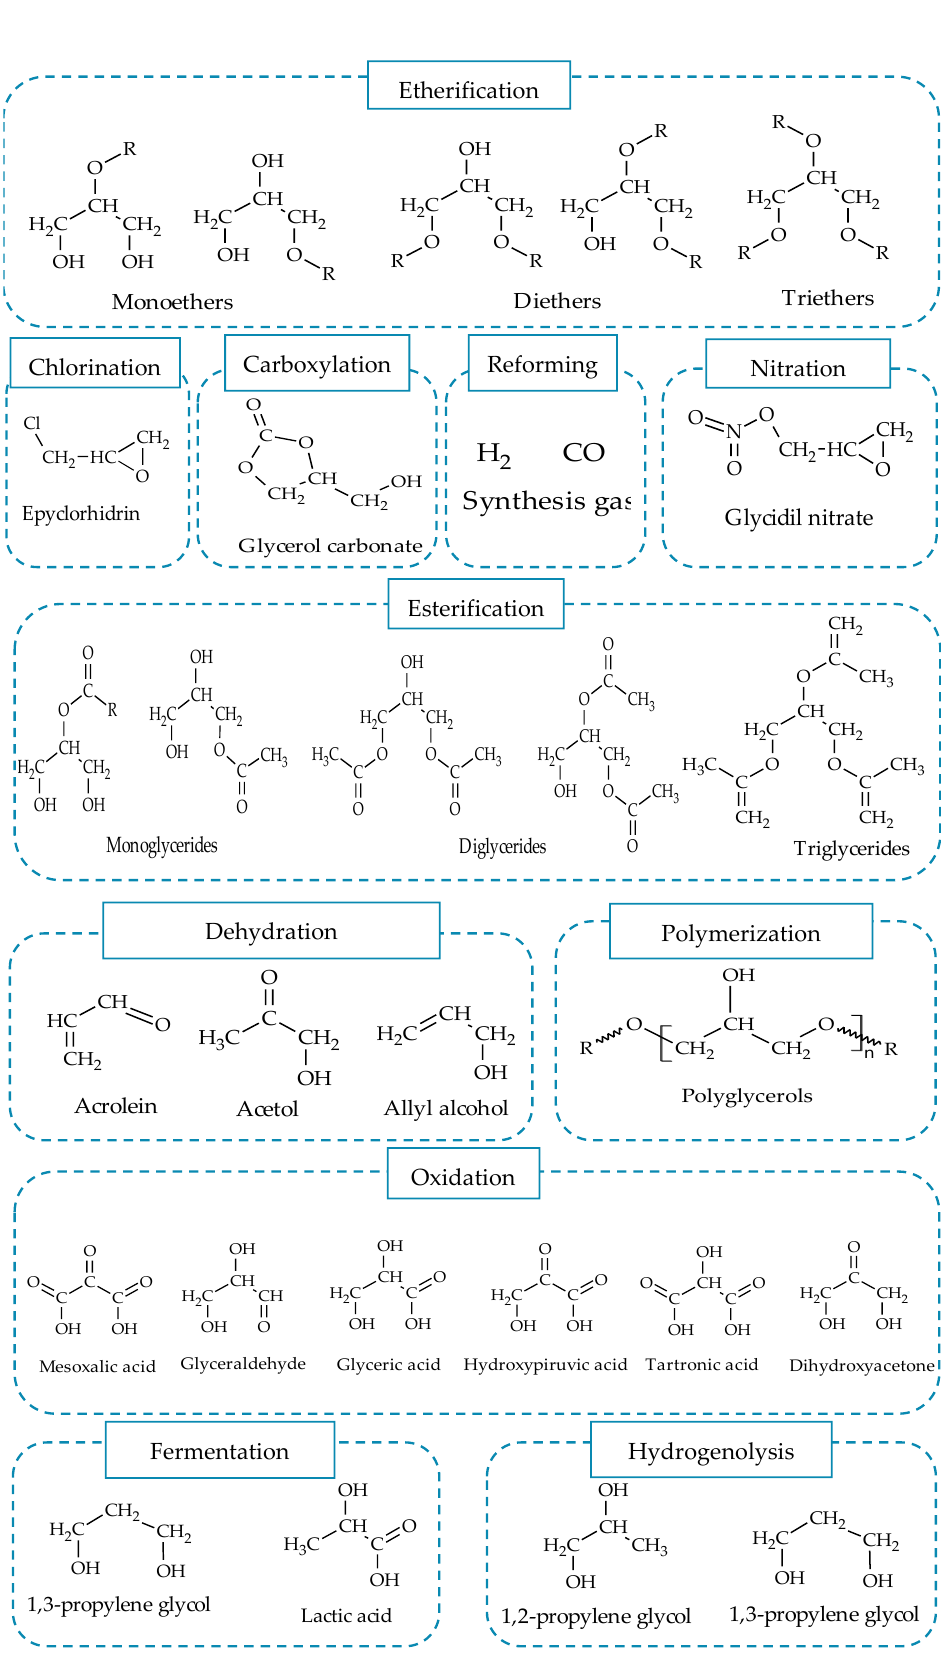
Figure 3. The processes for the transformation of glycerol into high value-added products.